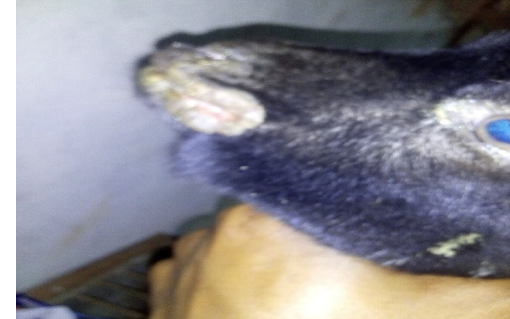
Fig. 7. Labial Orf-like lesions